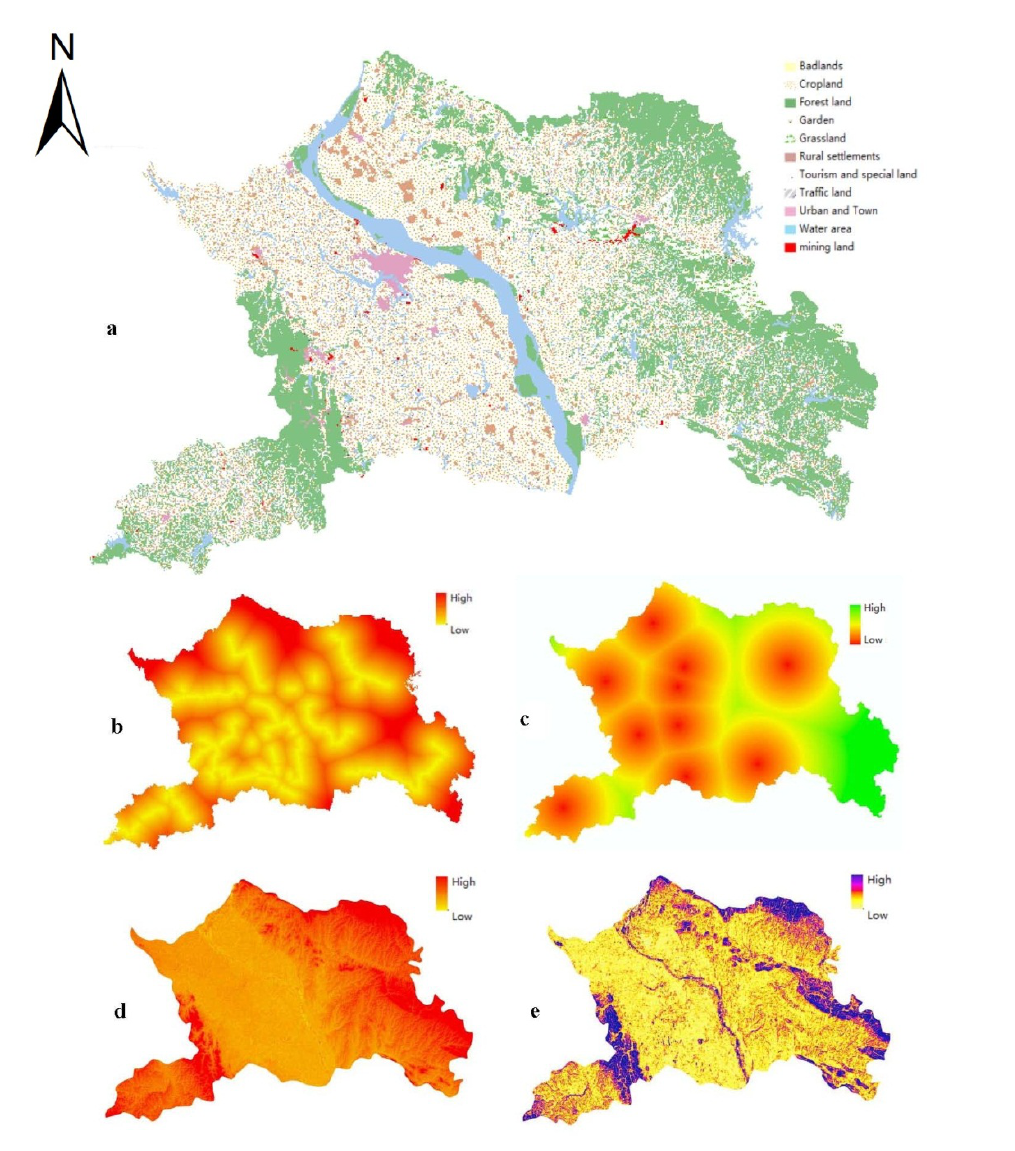
Figure 2. Main spatial data for the land-use zoning model: ( a ) Actual land-use map; ( b ) Distance from highways and railways; ( c ) Distance to center of towns; ( d ) Elevation; ( e )